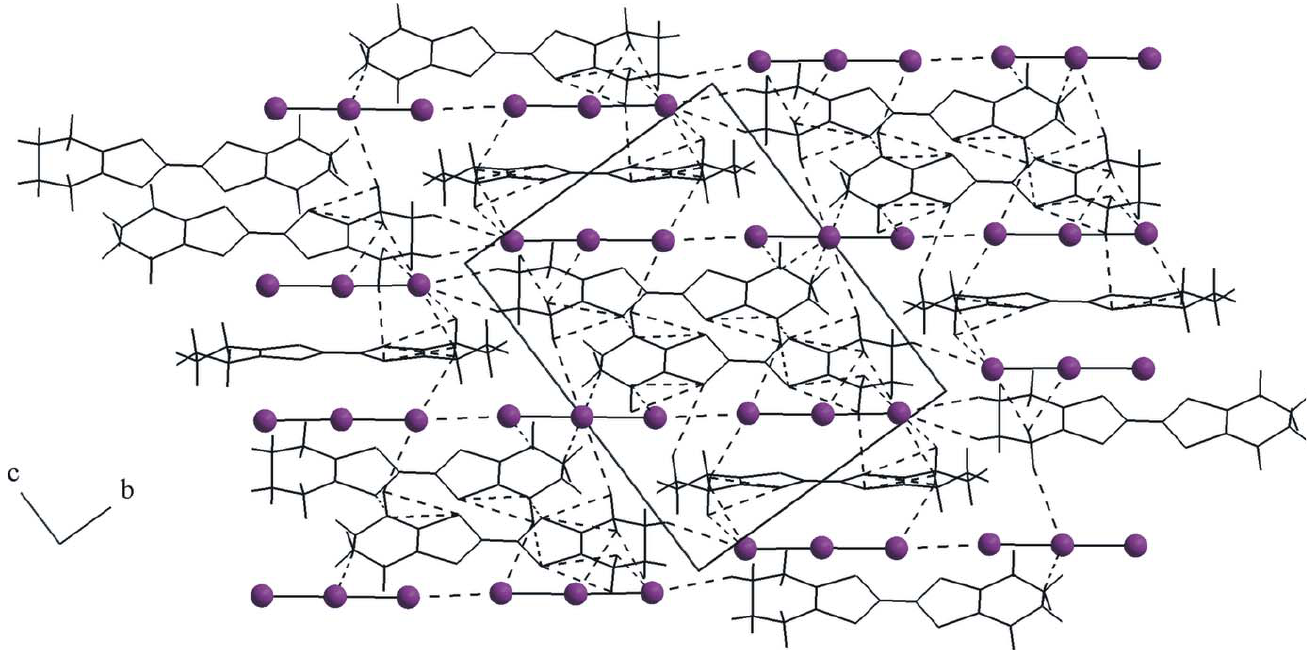
Figure 3 Section of the crystal structure of the title compound, (cid:2) -(OMTTF)I 3 , showing the three-dimensional hydrogen-bonded network built up by H (cid:2)(cid:2)(cid:2) I intermolecular interactions (shown as dashed lines). The I 3 (cid:3) units are linked by I (cid:2)(cid:2)(cid:2) I intermolecular interactions, also drawn as dashed lines, forming one-dimensional chains of nine I atoms. The figure is simplified for